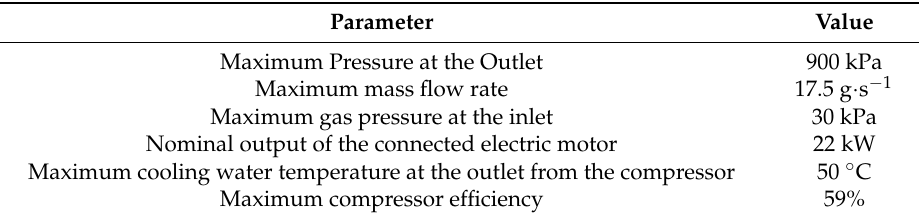
Table 1. Specification of the type TZW 60/S6 compressor.